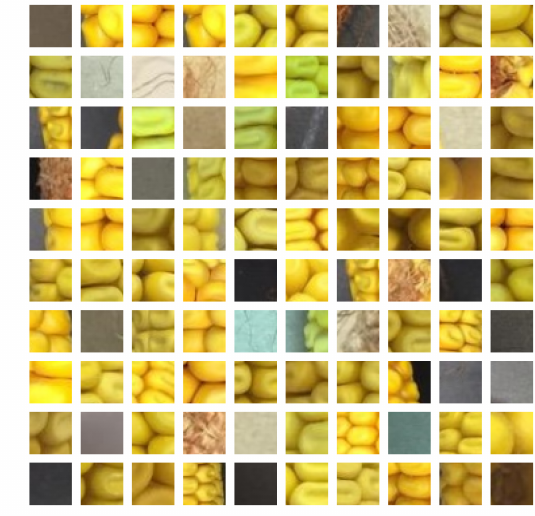
Figure 4. A random subset of non-kernel